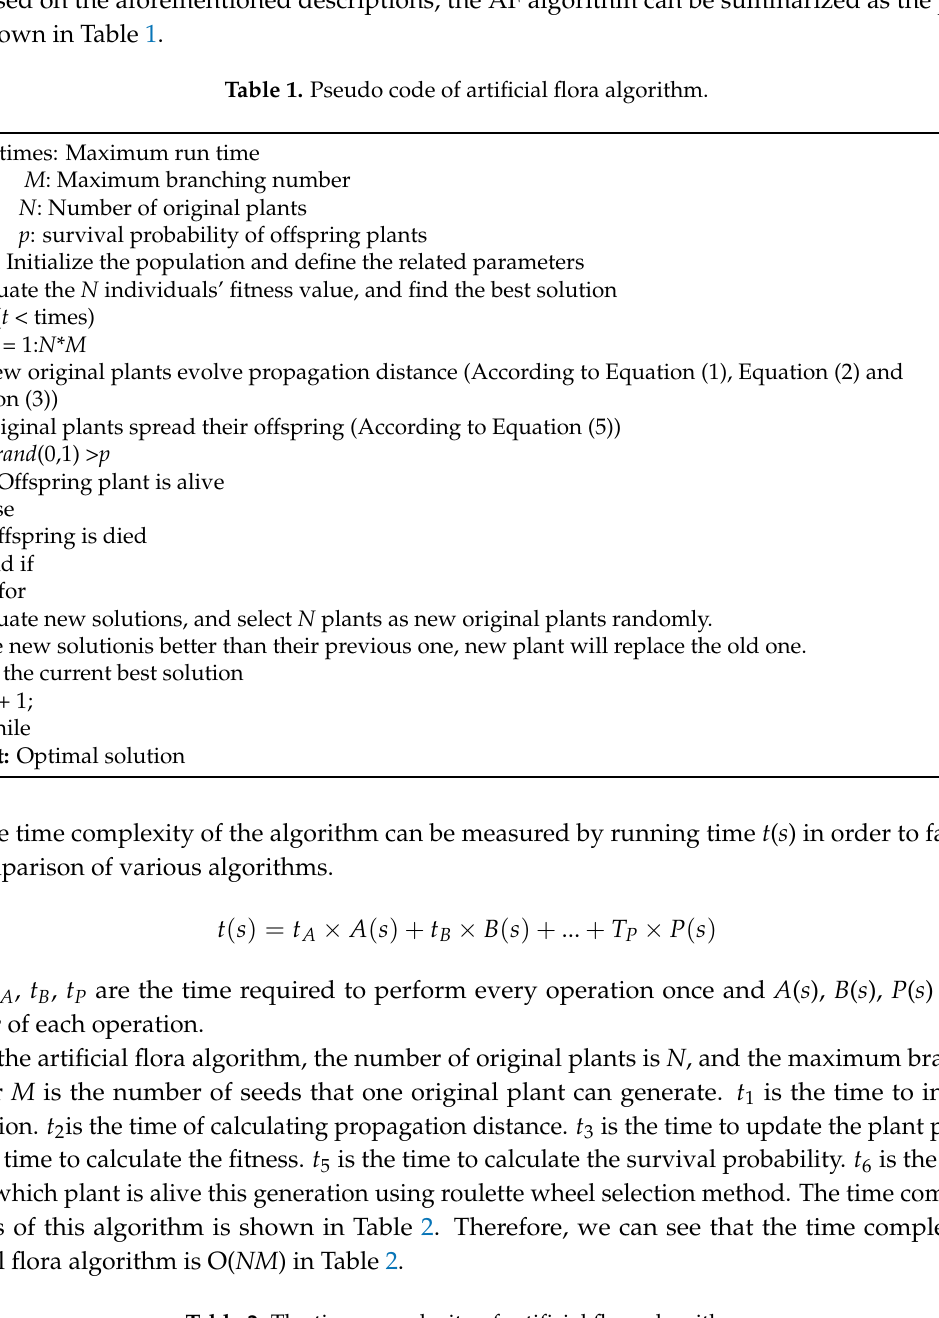
Table 2. The time complexity of artificial flora